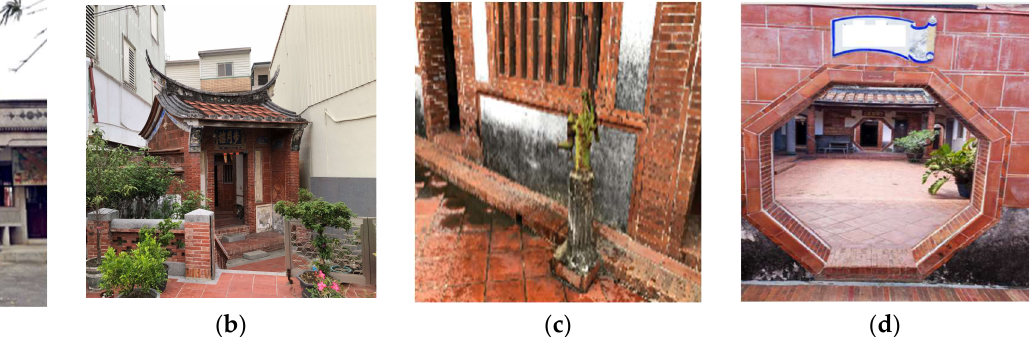
Figure 4. Rural cultural tourism played an important role during COVID-19. ( a ) The Xiao family ancient house was built over 200 years ago and has now become a cultural heritage; ( b ) The gate of the ancient house for defense. Here, a real war happened in 1895 in the Japanese occupation era; ( c ) groundwater for everyday life with furui (traditional pump); and ( d ) Gossip gate, a form of “Feng Shui” in Chinese, which means the gate can foster the safety and health of all families.